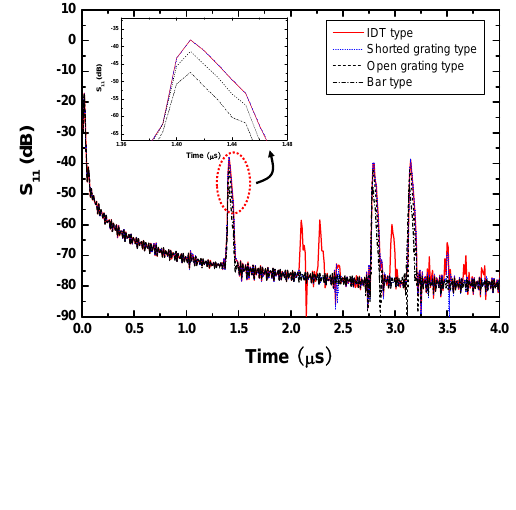
of the reflective delay line with SPUDTs and various types of Figure 6. Simulated S 11 reflectors based on COM